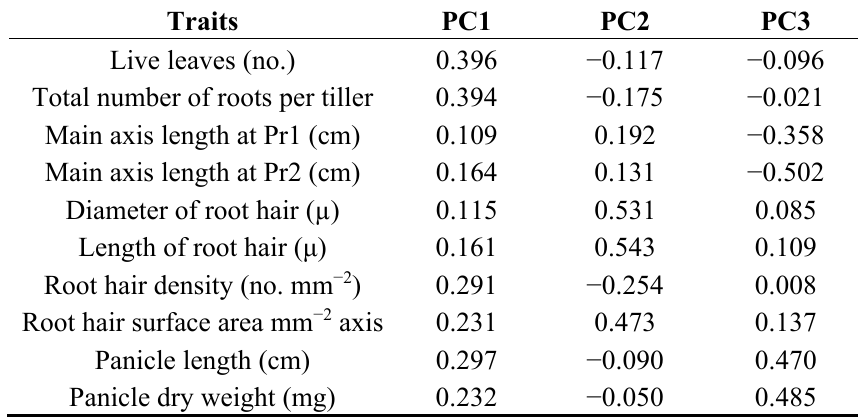
Table 2. Principal component analysis (PCA) of selected morphological traits of wheat varieties under PEG-treated hydroponic culture. PC, principal component; p , statistical significance; Pr, root bearing